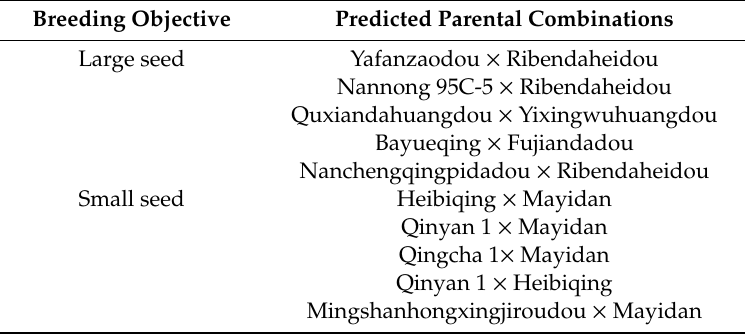
Table 4. The best parental combinations predicted from genome-wide association studies for 100-seed weight in